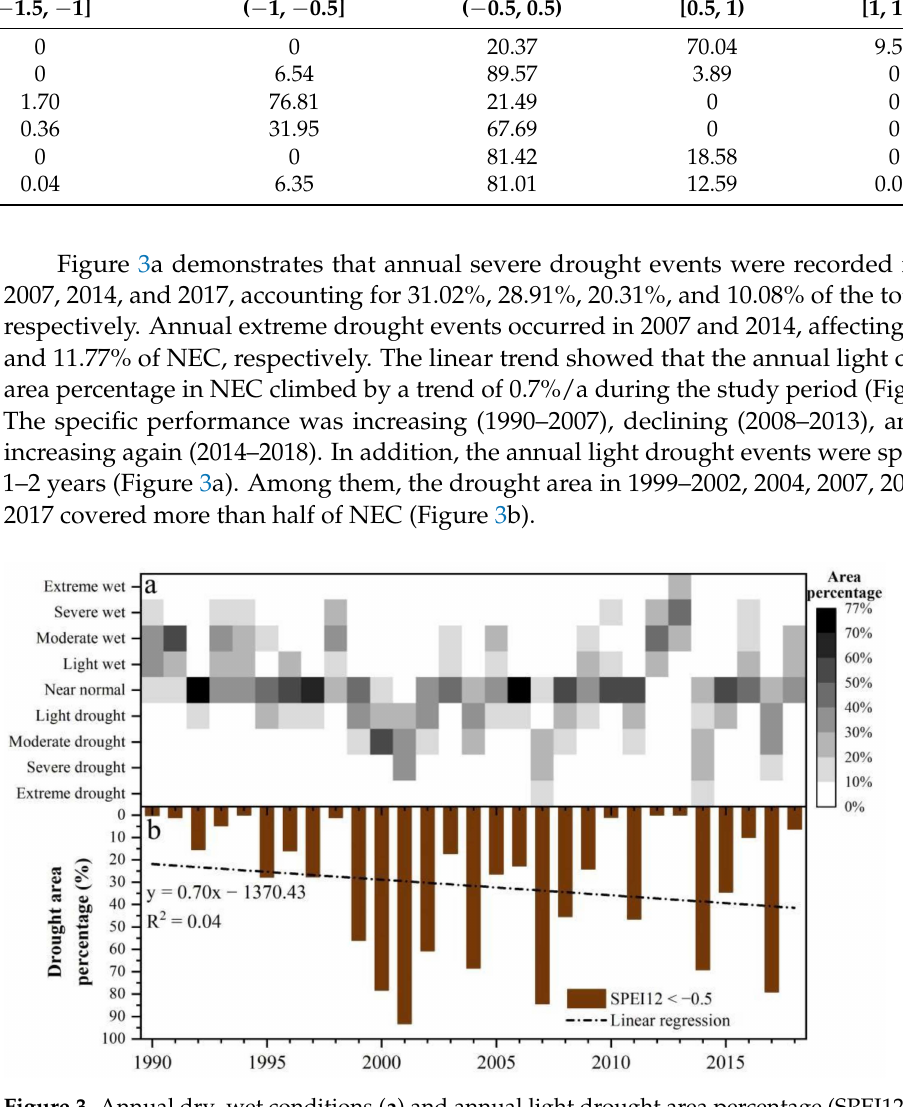
Figure 3. Annual dry–wet conditions ( a ) and annual light drought area percentage (SPEI12 < − 0.5), ( b ) in northeast China (NEC) from 1990 to